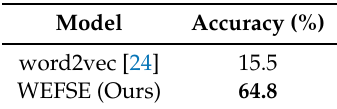
Table 8. The word analogy results for WEFSE and word2vec. Our model outperforms the word-based word representation. The bolded values represent the best